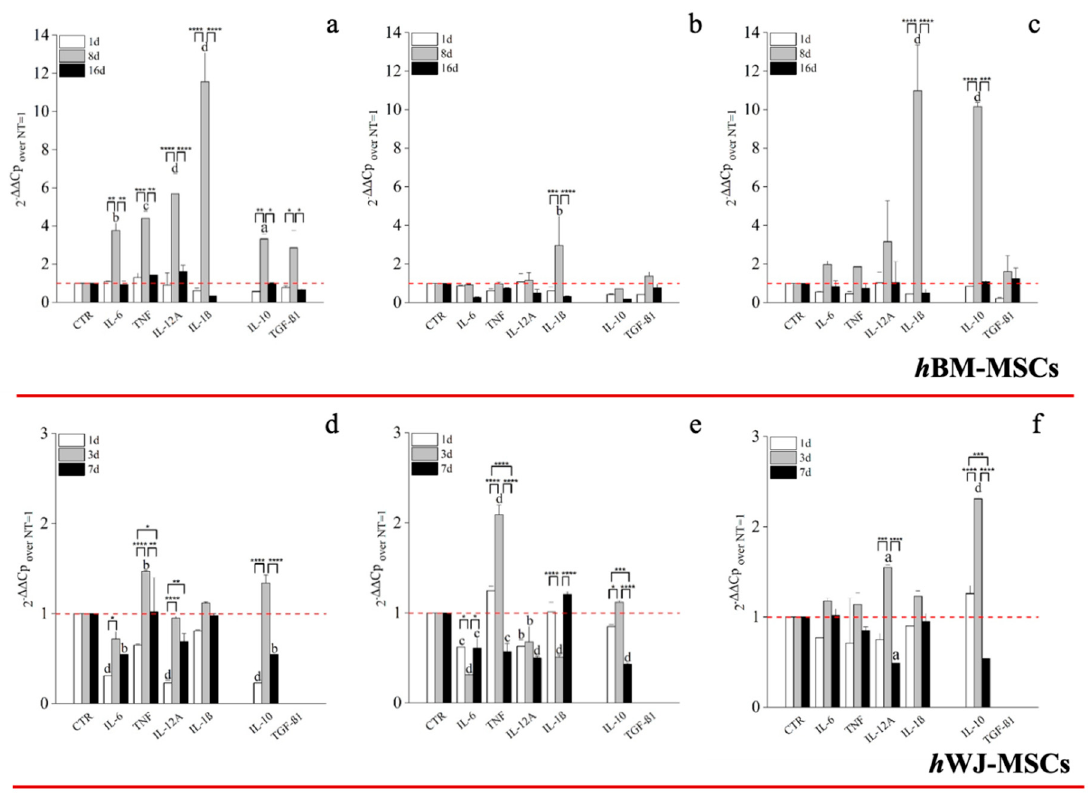
Figure 8. RT-PCR on the expression of cytokine by hBM-MSCs and hWJ-MSCs with the hGDF-5 concentration-dependent effect. The mRNA levels of both pro-inflammatory (IL-6, TNF, IL-12A and IL-1 β ) and anti-inflammatory (IL-10 and TGF- β 1) cytokines were monitored at hGDF-5 concentrations of 1 ng/mL ( a , d ), 10 ng/mL ( b , e ) and 100 ng/mL ( c , f ). Untreated cells for matched time-points selected were used for control purposes. Statistically significant differences are shown as * = p ≤ 0.05, ** = p ≤ 0.01, *** = p ≤ 0.005, **** = p ≤ 0.001; a = p ≤ 0.05, b = p ≤ 0.01, c = ≤ 0.005, d = p ≤ 0.001 compared to NT.